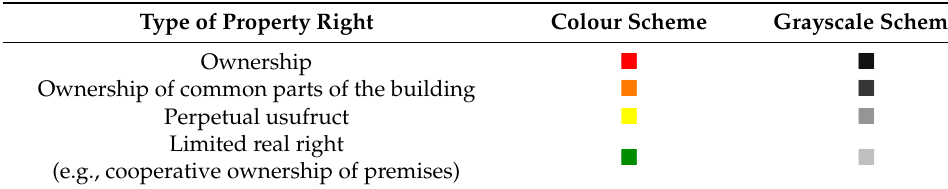
Table 1. Colors corresponding to visualized property rights.